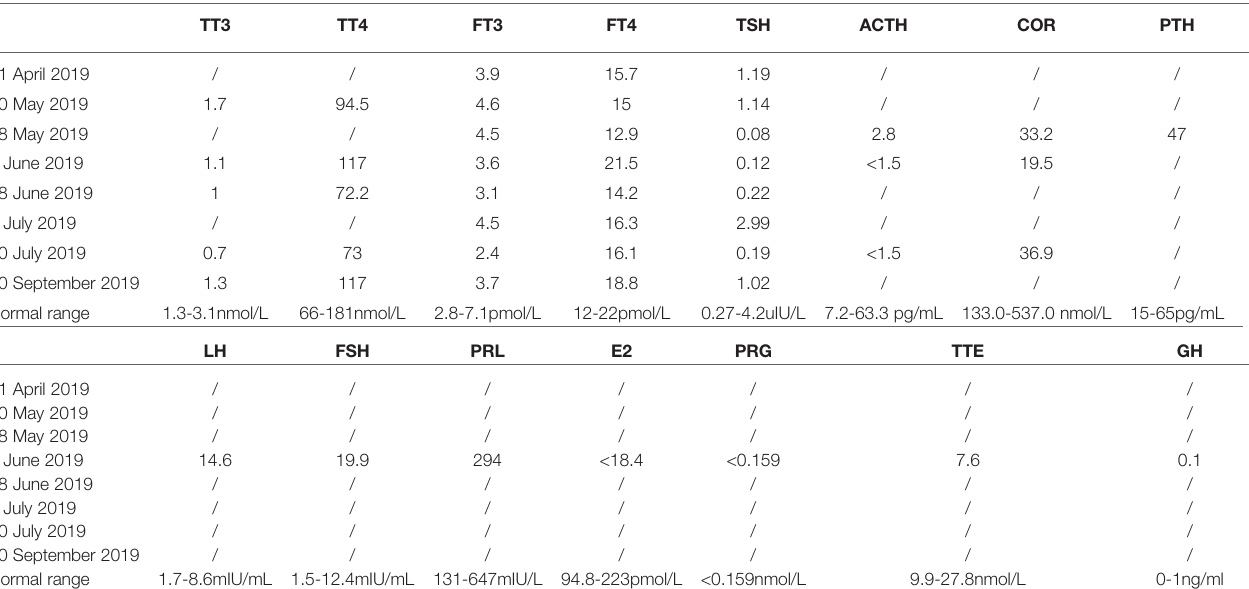
TABLE 1 | The hormone levels of this patient in various